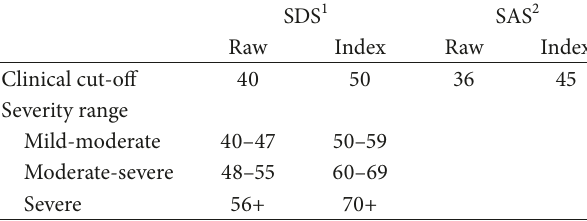
Table 1: Clinical cut-off and severity ranges. Table 2: Number of papers applying cut-offs correctly and incor-